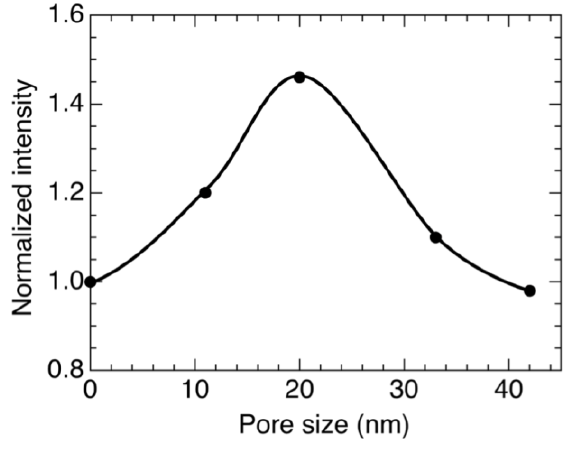
Figure 2: OH-radical production efficiency as a function of average pore diameter.